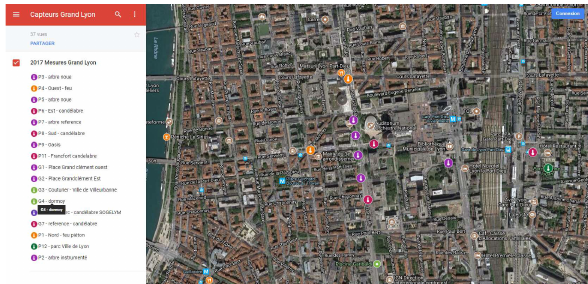
Figure 4. Garibaldi Street, location of measuring points.